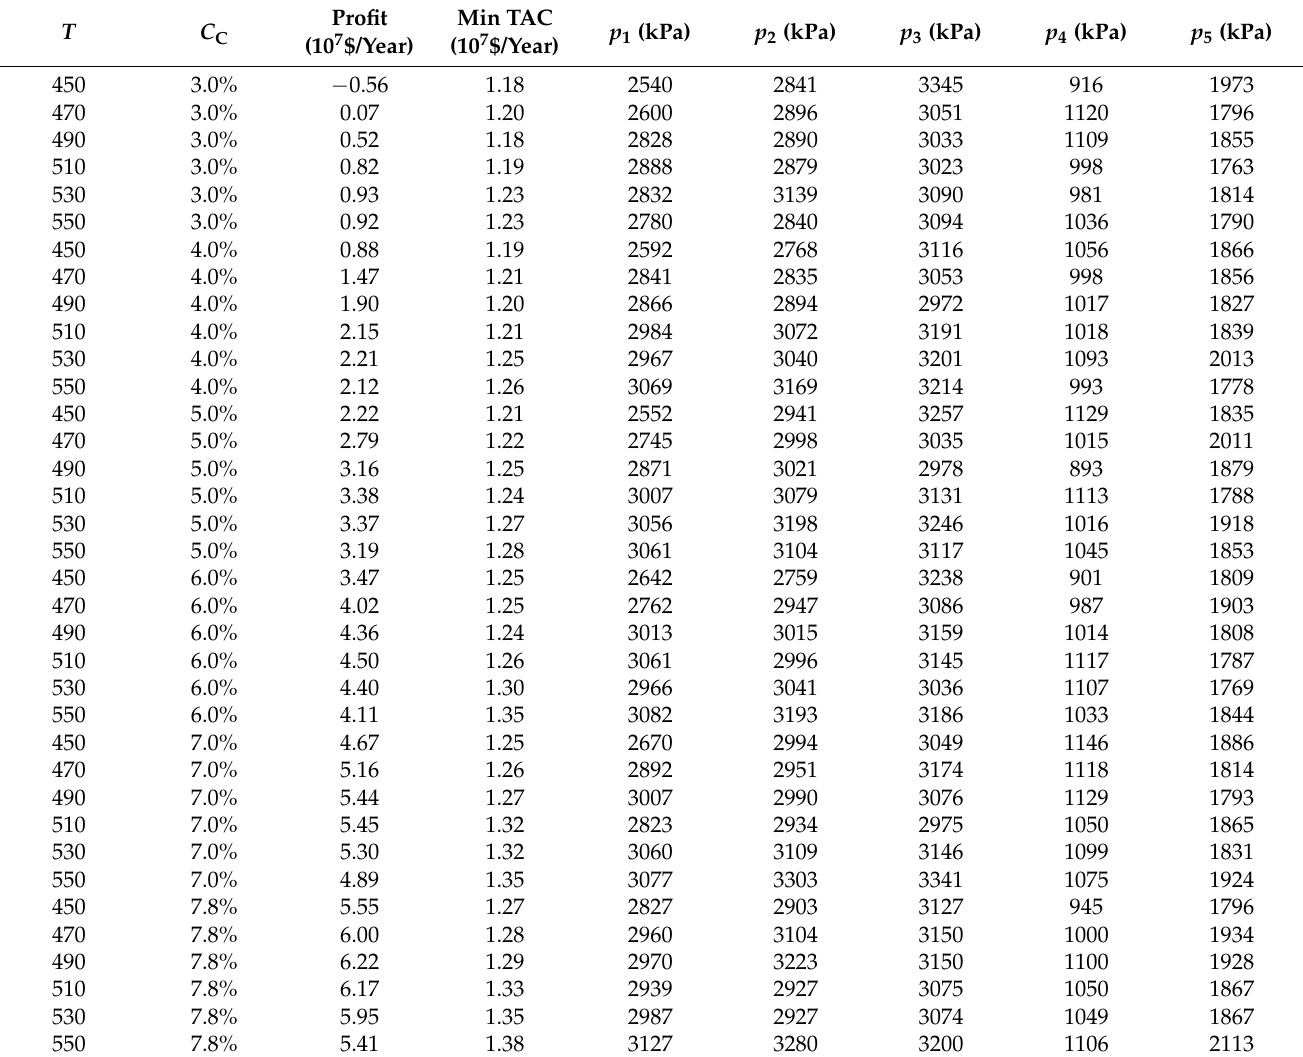
Table A3. Detailed results at different T and C C